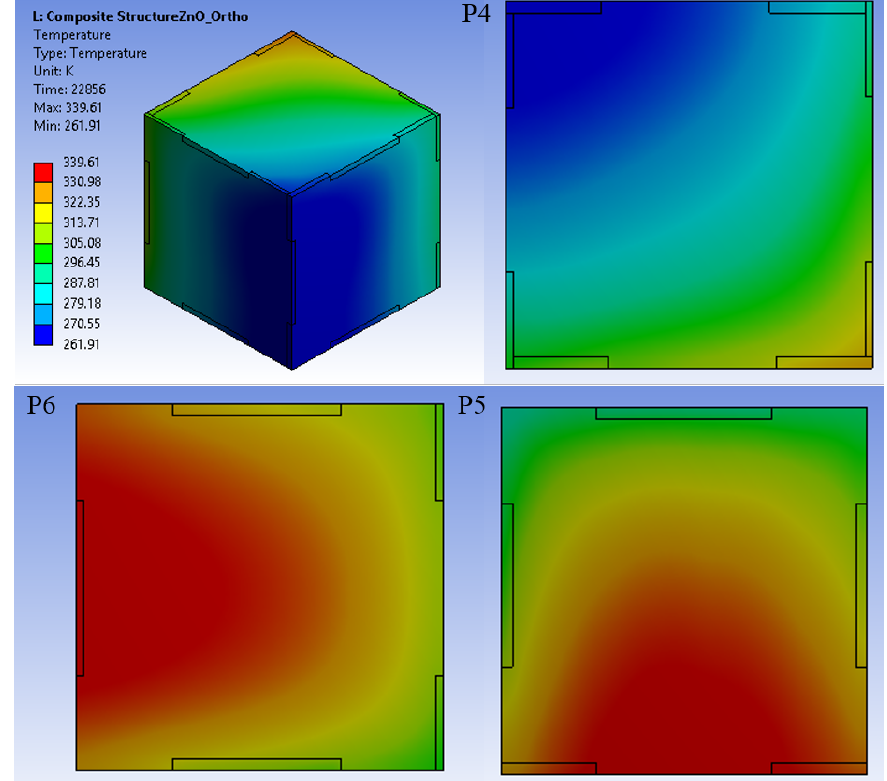
Figure 5. Temperature field on the surface of the CubeSat panels at t = 22,856 s ( β = 57 ◦